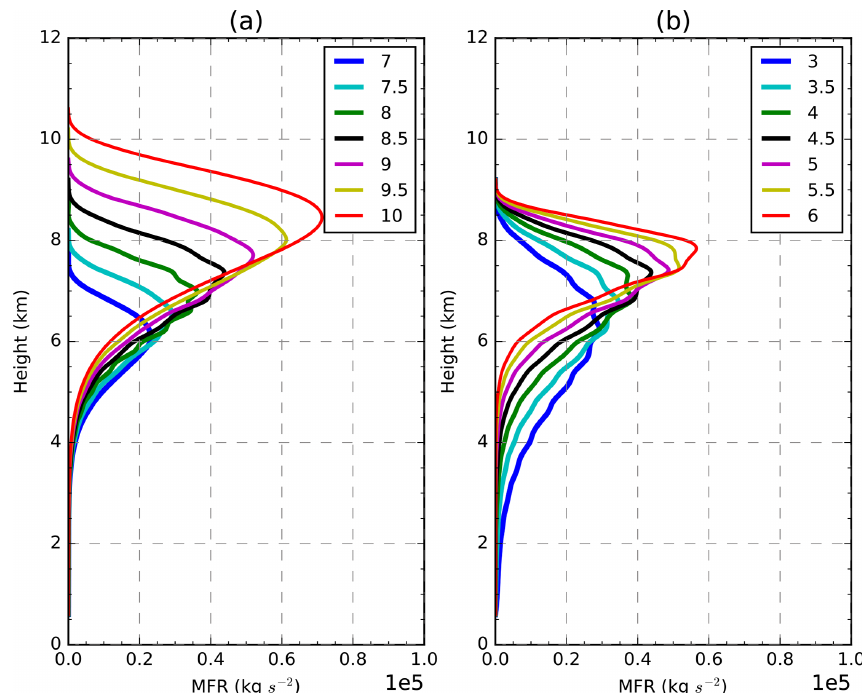
Figure 1. Vertical mass distribution for different (a) eruptive column top heights and (b) A Suzuki